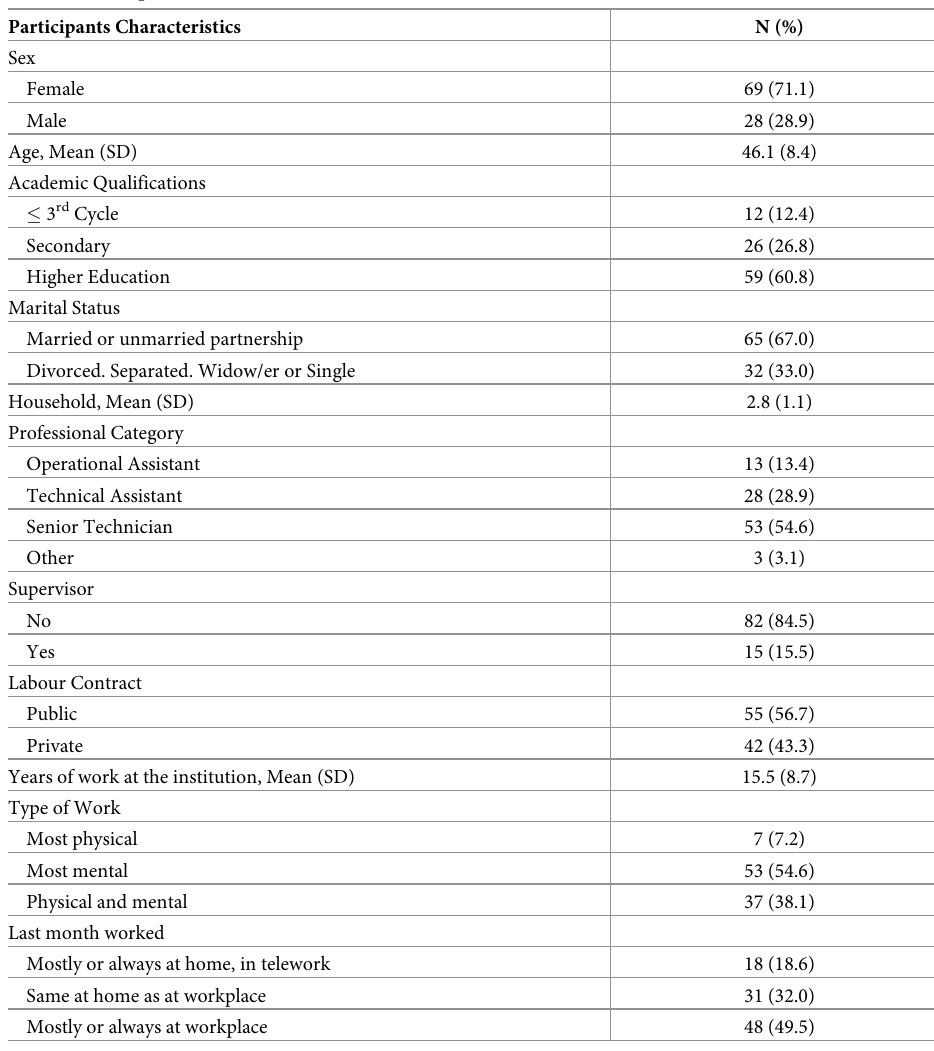
Table 1. Participants